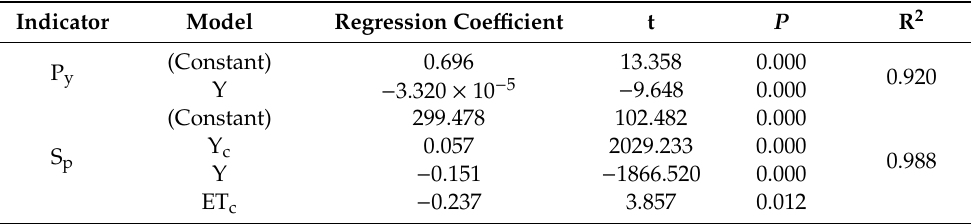
Table 2. Stepwise regression coefficient of indexes affecting water saving potential of maize.